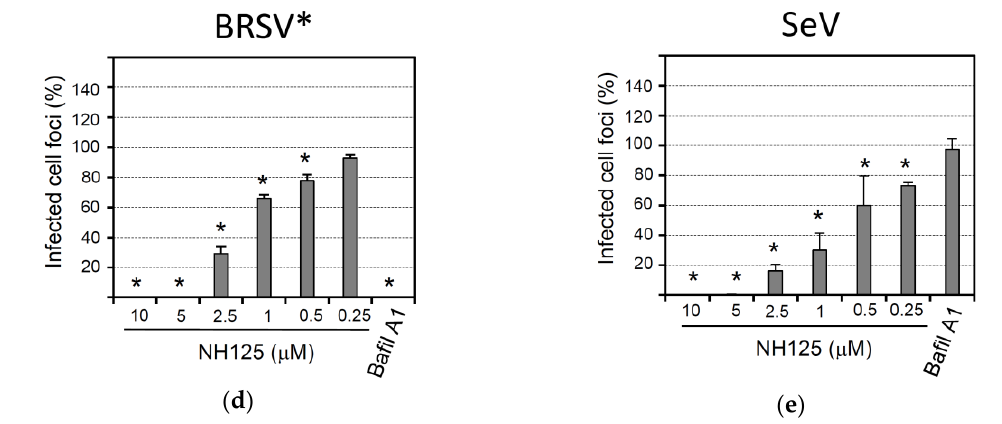
Figure 7. Broad-spectrum antiviral activity of NH125. BHK-21 cells were treated for 1 h with the NH125 using the indicated concentrations or with bafilomycin A1 (0.08 µM). ( a ) The cells were inoculated for 1 h with the indicated chimeric viruses (m.o.i. of 0.05 ffu/mL) in the presence of the inhibitor, washed and maintained in medium for five more hours. Secreted NanoLuc luciferase activity in the cell culture supernatant was determined with a luminescent substrate. The relative luminescence with respect to DMSO-treated control cells is shown. Mean titers and standard deviations of six parallel experiments are shown. ( b – e ) NH125-treated BHK-21 cells were inoculated for 1 h in the presence of inhibitor with 100 ffu/well of either VSV* ( b ), BTV-8 ( c ), BRSV* (strain ATue51908) ( d ), or Sendai virus (SeV, strain Fushimi) ( e ). The cells were washed and maintained for 20 h in medium with inhibitor and methylcellulose. The number of infected cell foci was determined and expressed percentage infected cell foci relative to DMSO-treated cells. Mean titers and standard deviations of 6 parallel experiments are shown. Asterisks indicate significantly reduced number of cell foci compared to the DMSO